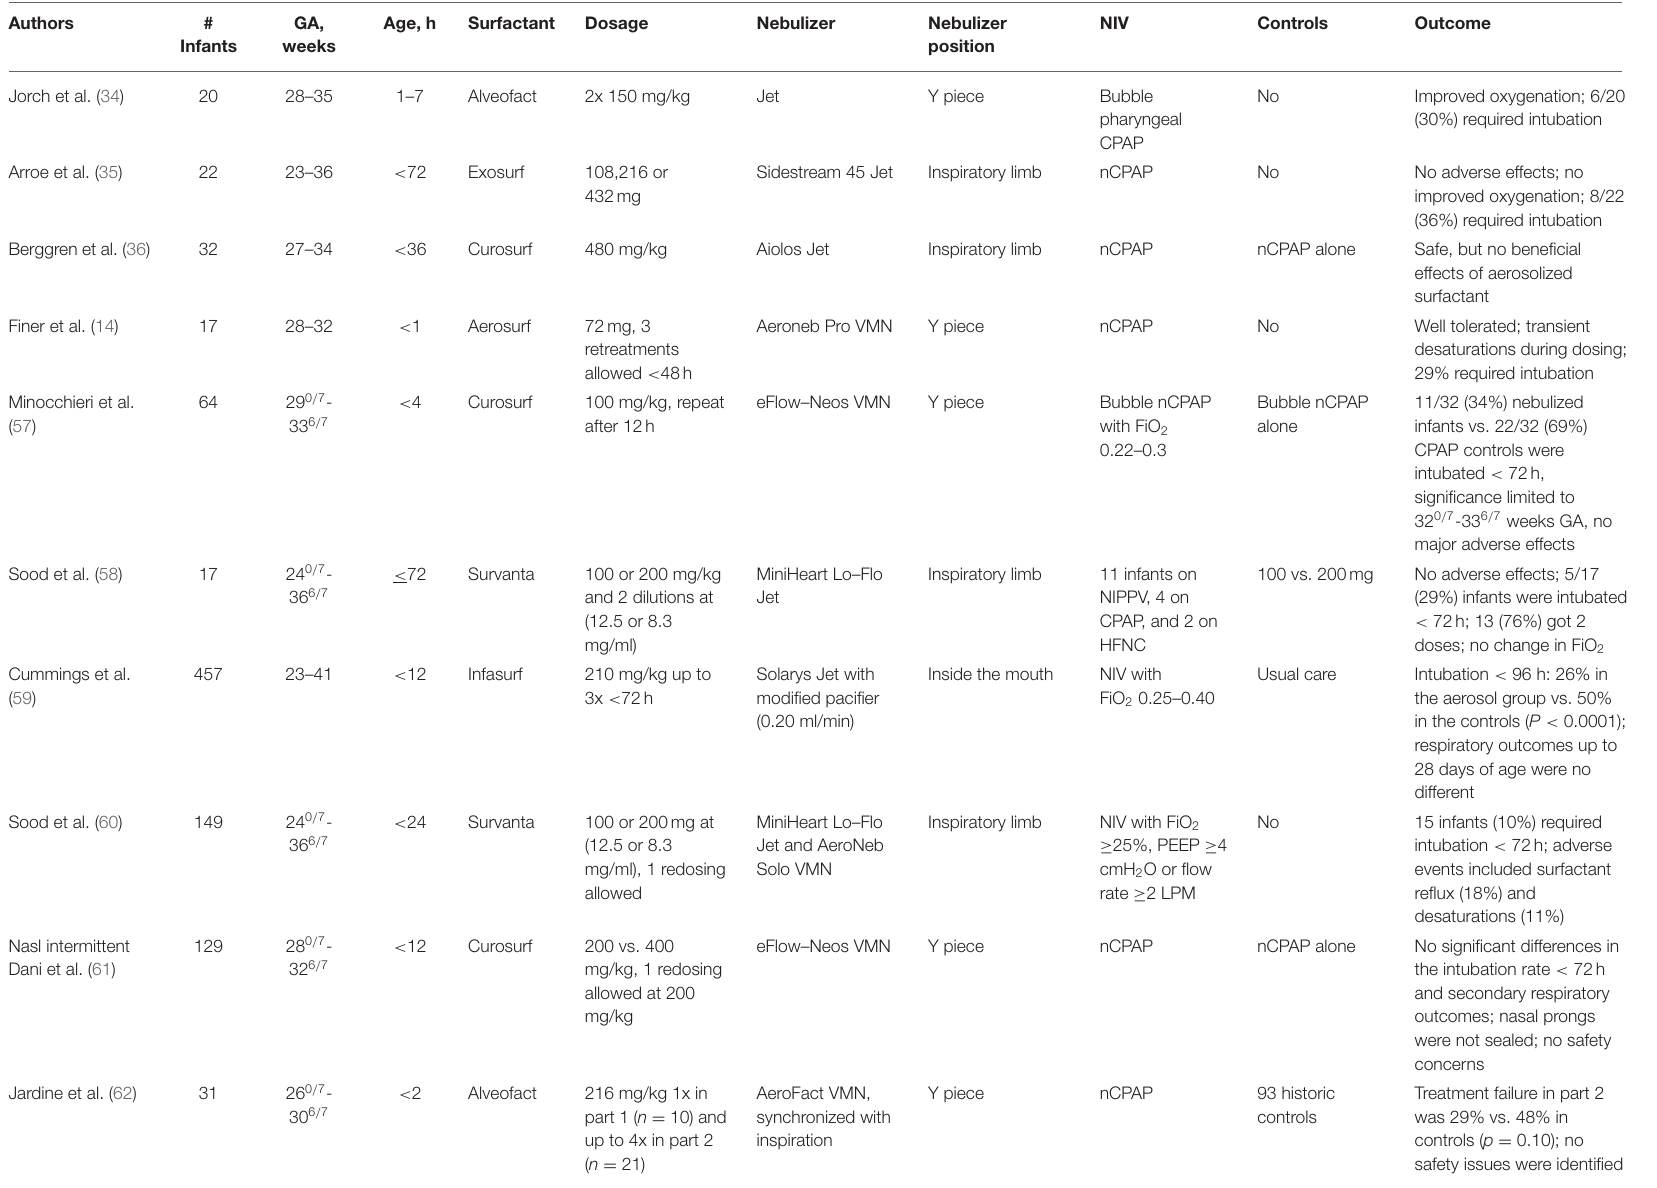
TABLE 2 | Summary of aerosolized surfactants and nebulizers in clinical studies of preterm infants supported with nasal CPAP